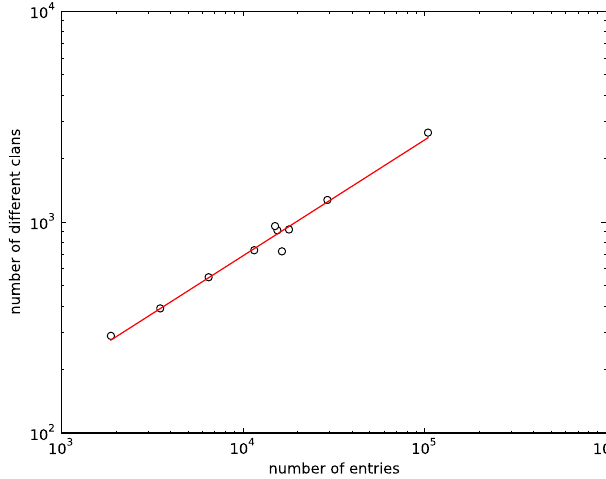
FIG. 8. For each jokbo , we plot the number of distinct clans N versus the total number of entries N scale. We calculate the red line via a linear regression to Heaps ’ law [65] using the expression N ≈ 0 . 55 ð 7 Þ and an intercept of b of a J confidence